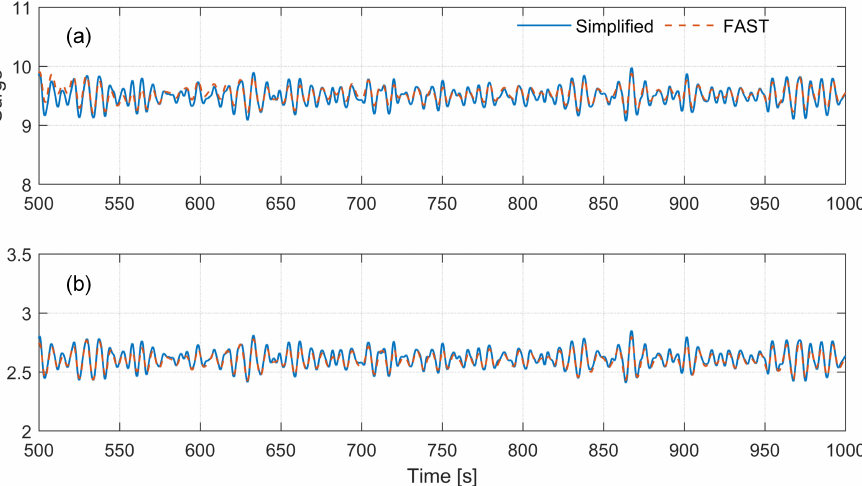
Figure 16. Time response of motion RAO for the spar-buoy floater under irregular waves: ( a ) Surge; ( b )